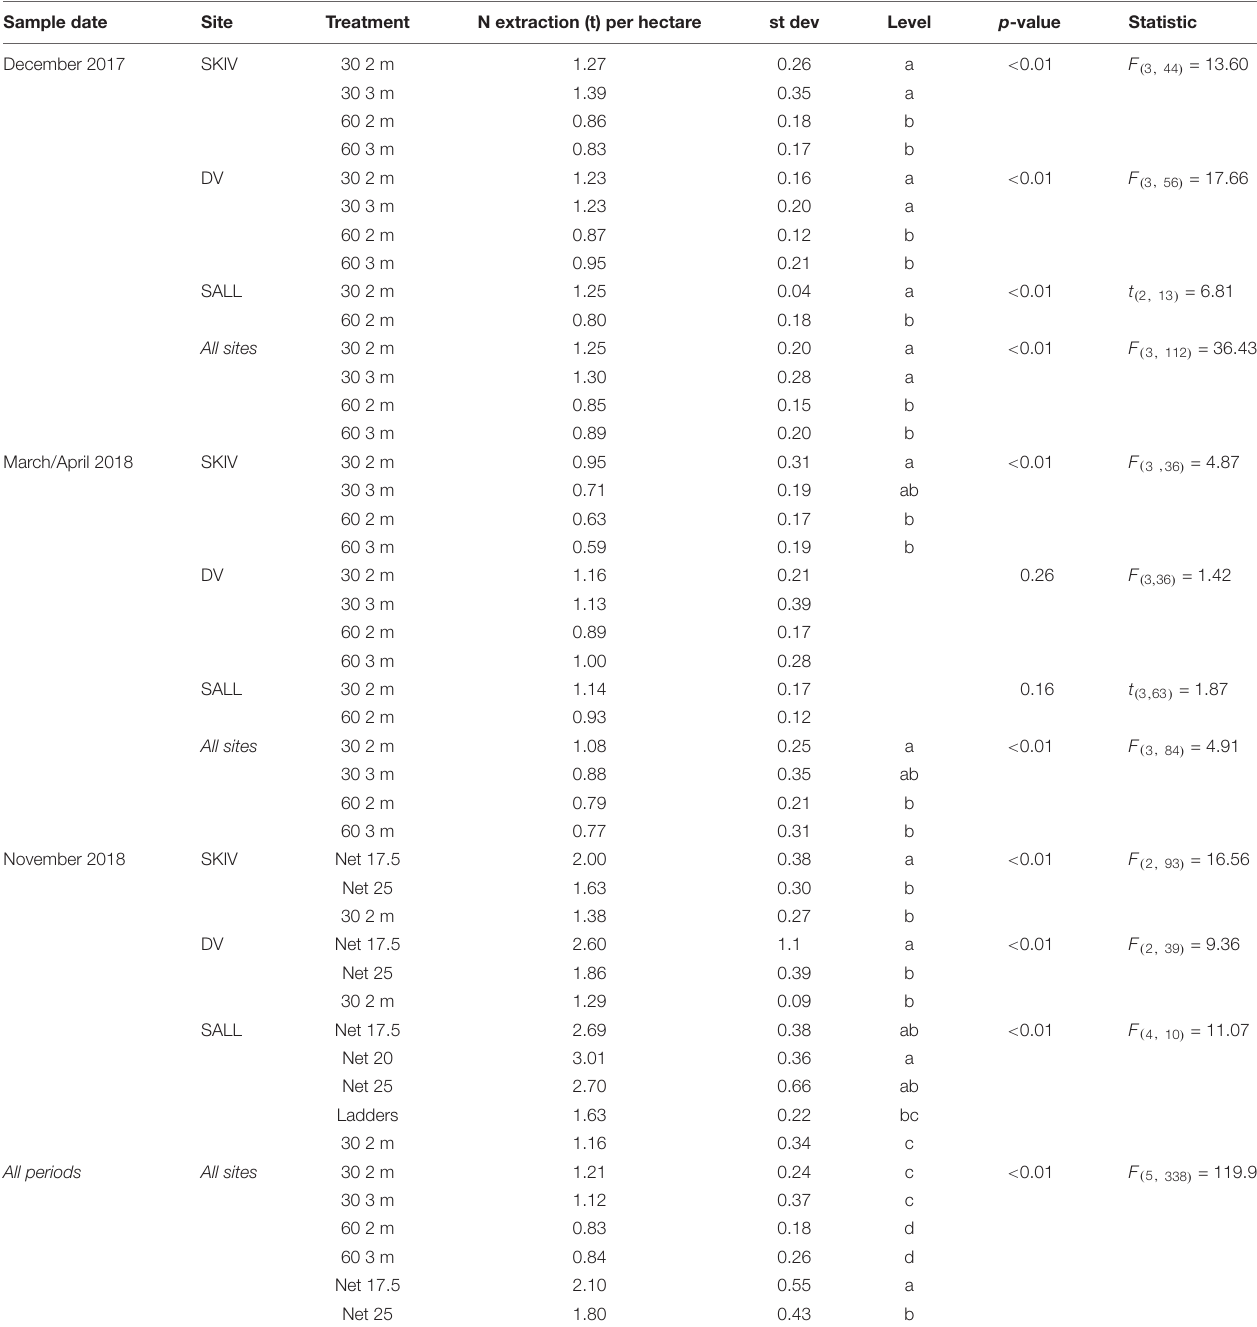
TABLE 1 | Total Nitrogen yield (tons) per hectare from the 2017 and 2018 growth cycle by potential harvest dates of belt spat collector treatments and alternative